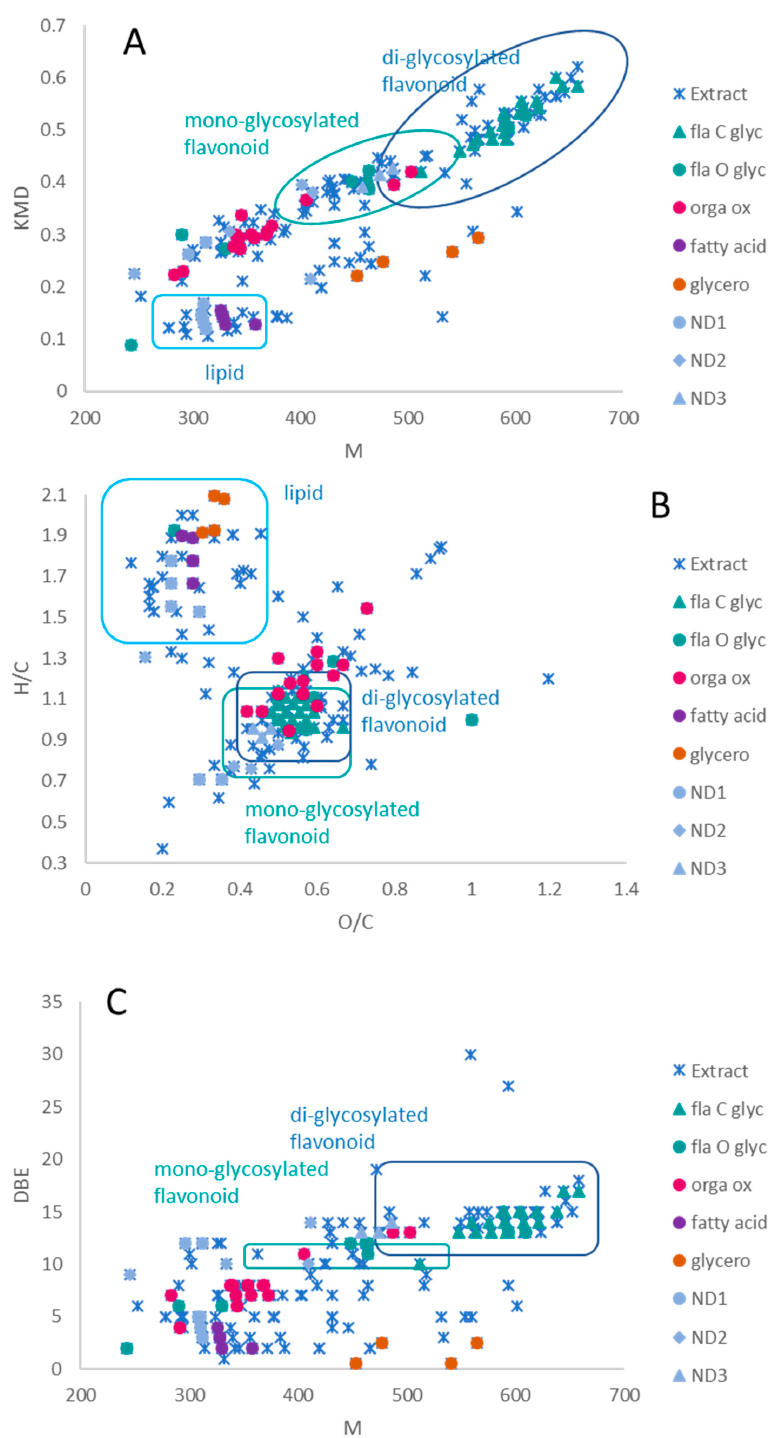
Figure 2. ( A ) Two-dimensional Kendrick molecular mass plotted against the Kendrick mass de- fect (KMD); ( B ) van Krevelen diagram showing the O/C ratio versus the H/C ratio; ( C ) double bond equivalent plot as a function of molecular weight. The blue crosses indicate the assigned molecule for corn silk extract analyzed in negative ionization mode. The ions clustered in the molecular network are labeled by the colored full forms, corresponding to molecular families (fla C glyc = flavonoid C -glycosylated; fla O glyc = flavonoid O -glycosylated; orga ox = organooxygen; fatty acid; glycero = glycerophospholipid; ND = not determined). The circled areas indicate the areas of the molecular families constructed from the Extrasynthese